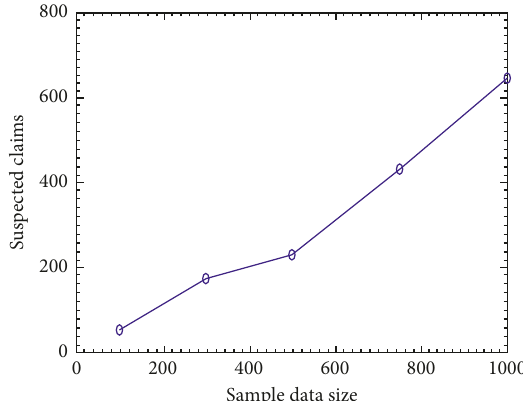
Figure 15: Detected fraud trend on the tested claims dataset.